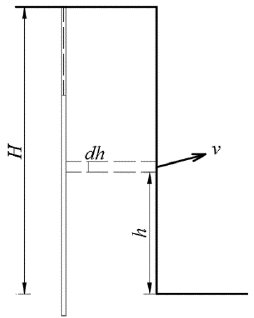
Figure 3. Profile micrometer body.